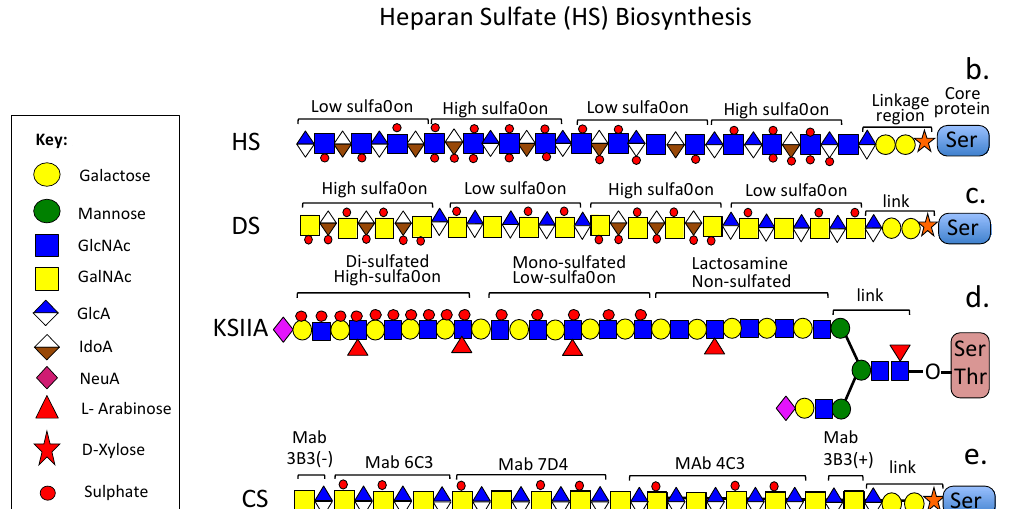
Figure 2. Variation in HS sulfation in a number of biological tissues and in GAG side chain structure. ( a ) Heatmap depicting the expression of twenty GAG biosynthetic enzymes demonstrating transcript expression levels for HS in 37 human tissues based on RNA sequencing (normalized transcripts per million, nTPM). Hierarchical clustering is shown based on the Pearson correlation. Data were obtained using the Genotype-Tissue Expression (GTEx) Program based on The Human Protein Atlas version 21.0 and Ensembl version 103.38. Figure modified from [24]. ( b – e ) Areas of high and low sulfation regions in putative GAG chains and specific regions in CS chains identified by a range of mAbs to CS sulfation motifs used in the assembly of CS chains. Figure 2a modified from Basu et al. [24] Reproduced under the Creative Commons Attribution CC-BY 4.0. with permission of The American Physiological Society.